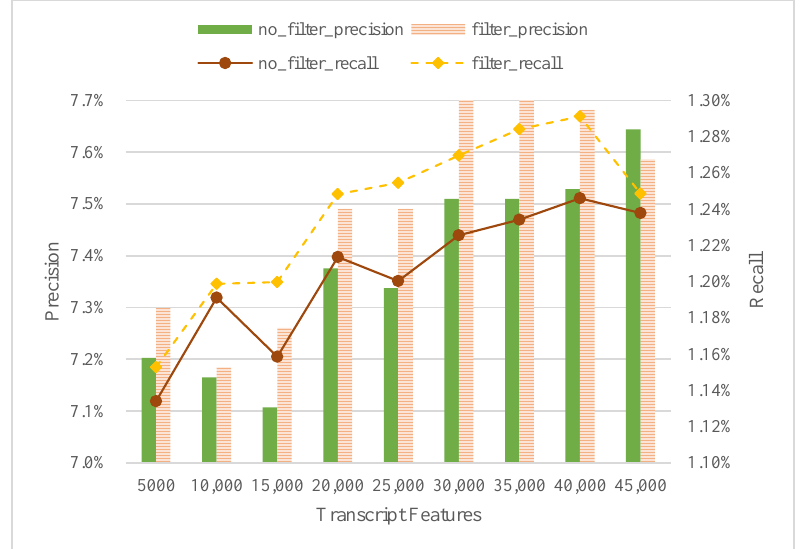
Figure 4. Precision and recall comparison with and without filtering title terms for different amount of transcript features with 10 title